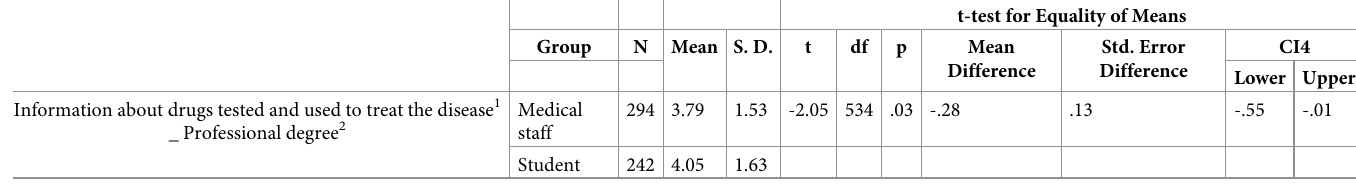
Table 7. Significant t test for information about drugs used to treat the virus and professional degree.